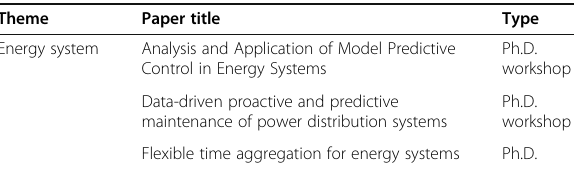
Table 1. Themes of the 13 poster abstracts from Energy Informatics. Academy (EI.A) Asia 2021